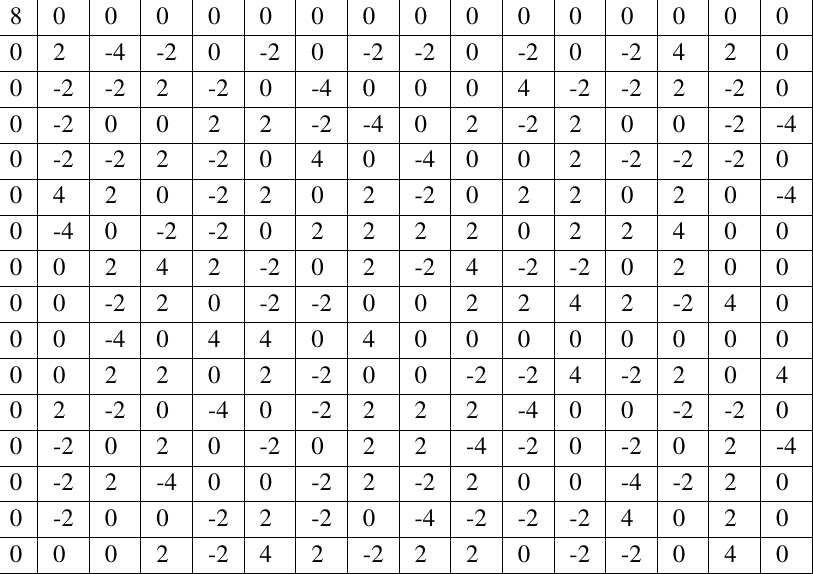
Table 4. The linear approximation of S1 (S3 new GOST S-box)